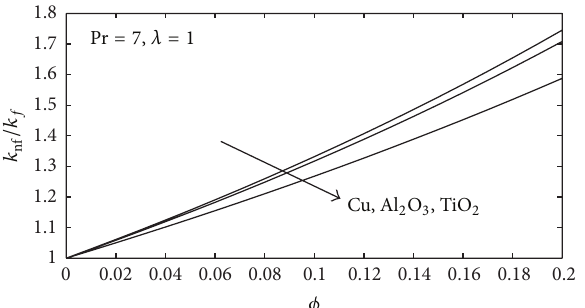
Figure 10: Variation of thermal conductivity ratio with 𝜙 for different types of nanoparticles when Pr = 7 and 𝜆 = 1